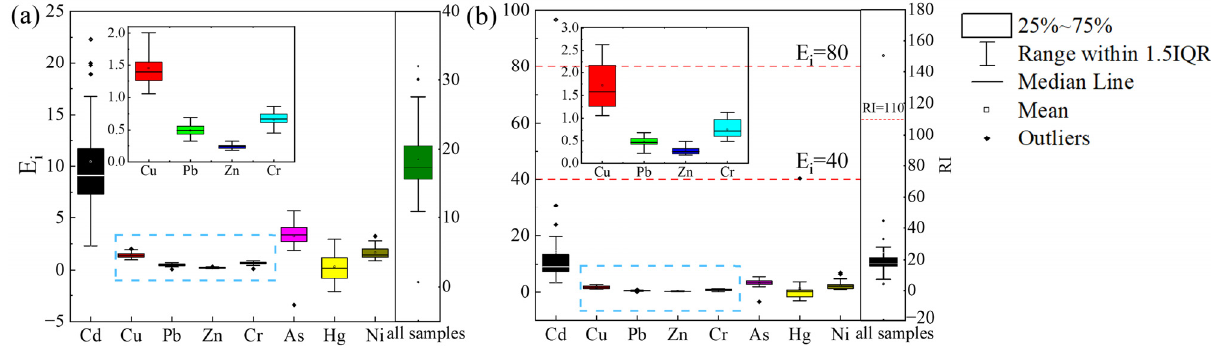
Figure 5. E i of heavy metal in soil planted with potato ( a ) and hulless oats ( b ) in Bashang